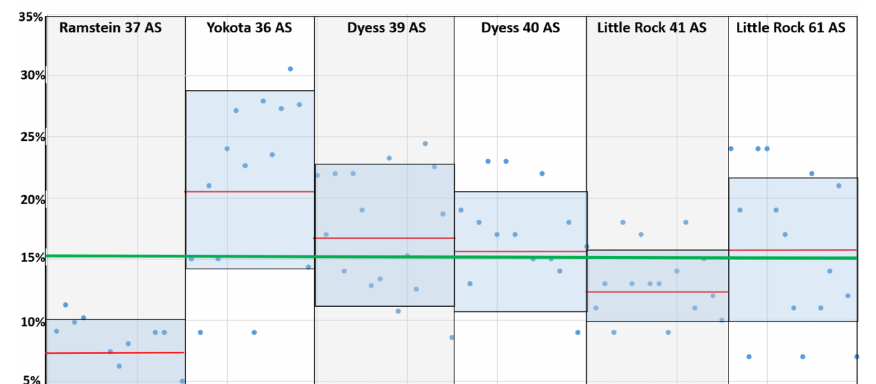
Figure 4. Other flight time as